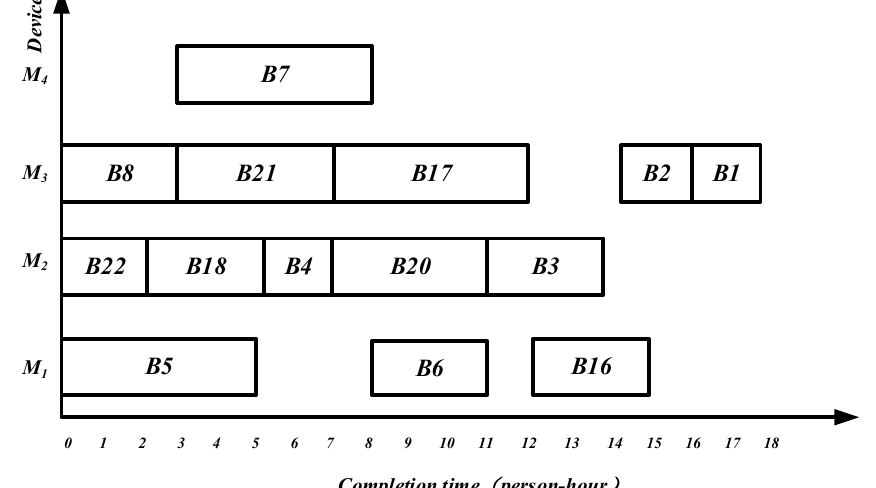
with 20 person ‐ hours. 1